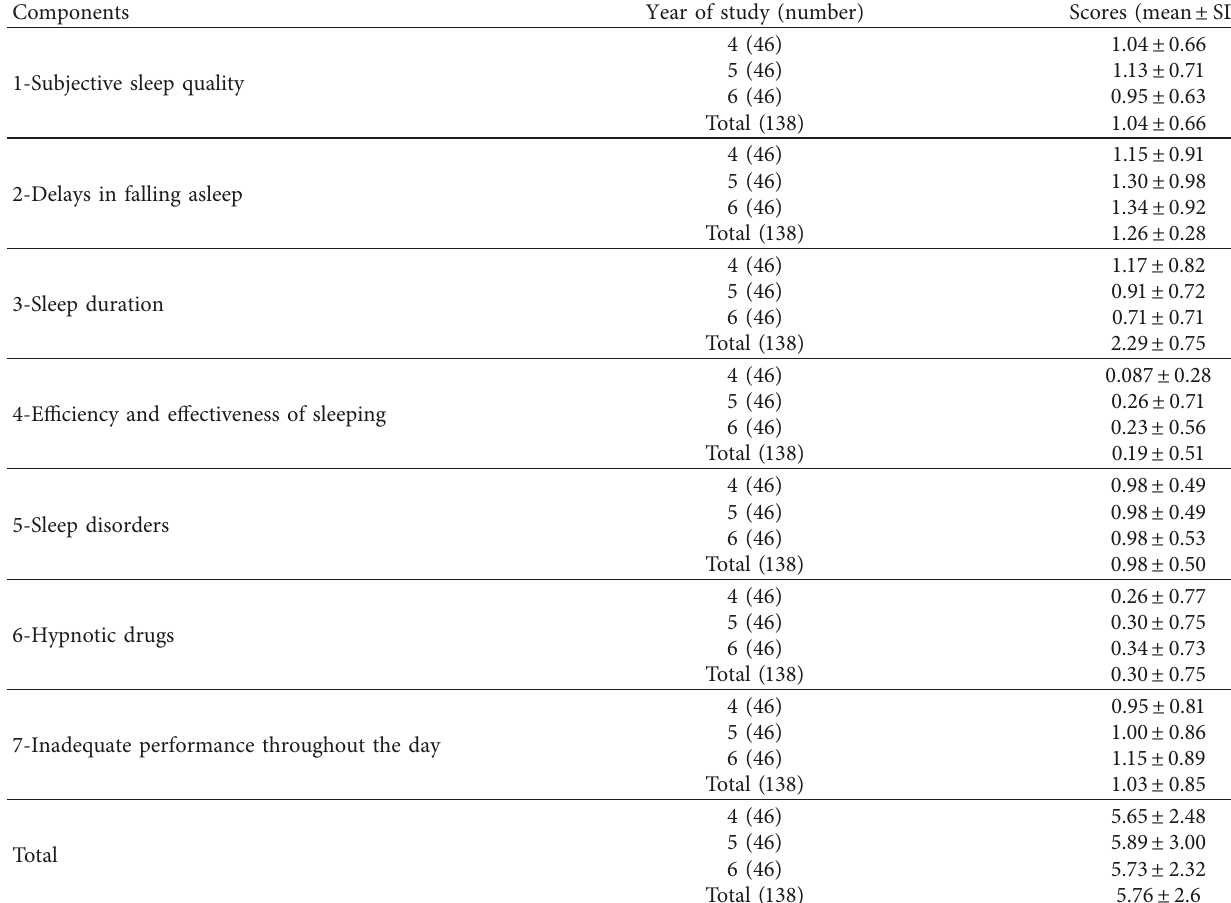
Table 2: The mean scores of the 7 components of the